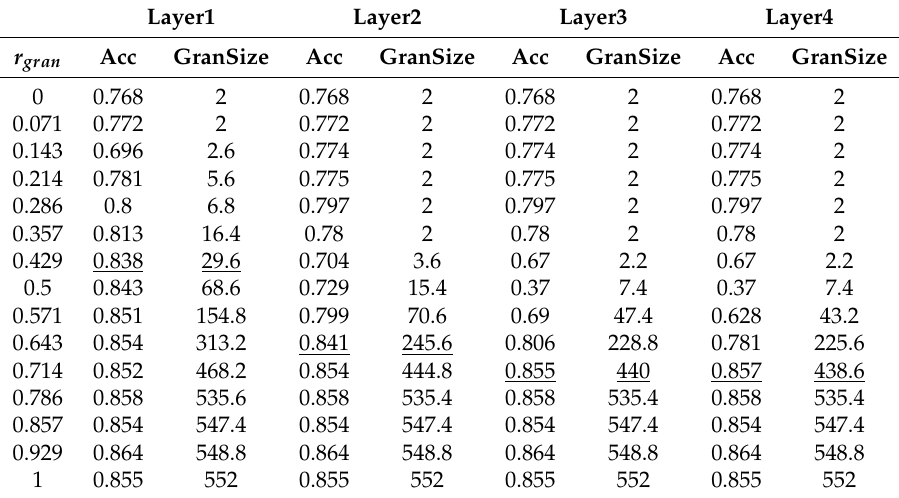
Table 16. CV-5; Result of experiments for multi-layer c-d granulation with use of kNN classifier; data set Australian credit; r gran = Granulation radius, Acc = Average accuracy for the considered layer, GranSize The mean size of granular decision system for the considered layer.